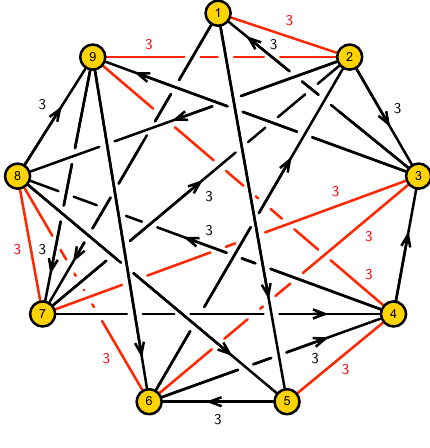
Figure 14 . Quiver for Y 3 , 1 ( CP 2 )